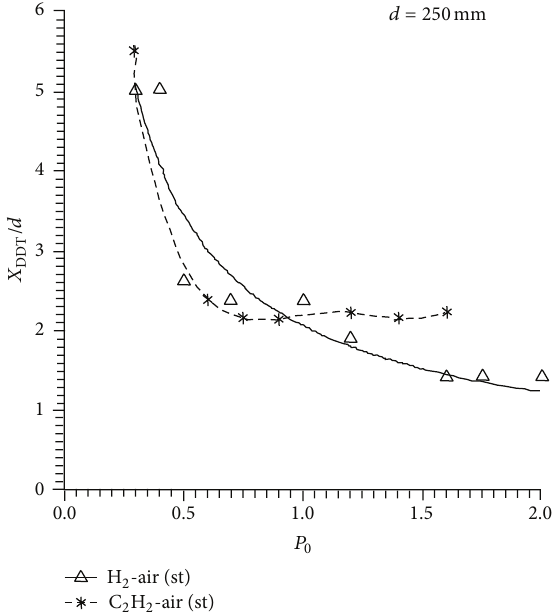
Figure 27: DDT distance (normalized on tube diameter) on initial mixture pressure (atm) for some fuel-air